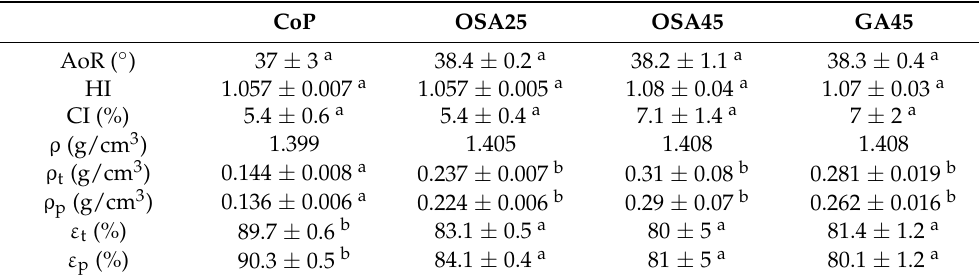
Table 5. Mean values of angle of repose (AoR), Hausner index (HI), Carr index (CI), real density ( ρ ), bulk density of tapped and poured powder ( ρ t ; ρ p ), and porosity of tapped and poured powder ( ε t ; ε p ) of the different powder samples (codes according to Table 1).